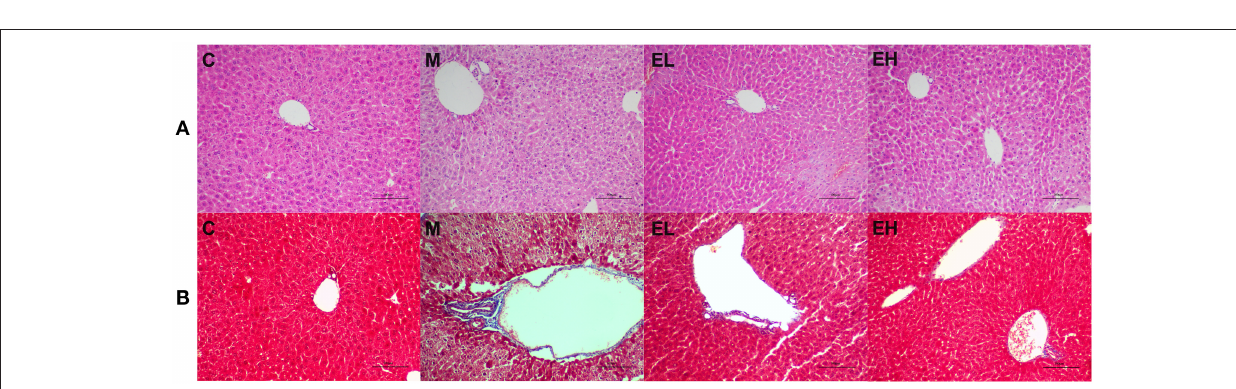
FIGURE 5 | Effect of ellagic acid on hepatic histopathology feature of alcohol induced ALD mice. (A) H&E staining; (B) MAS staining. C, normal group; M, model group; EL, low dose of ellagic acid group; EH, high dose of ellagic acid